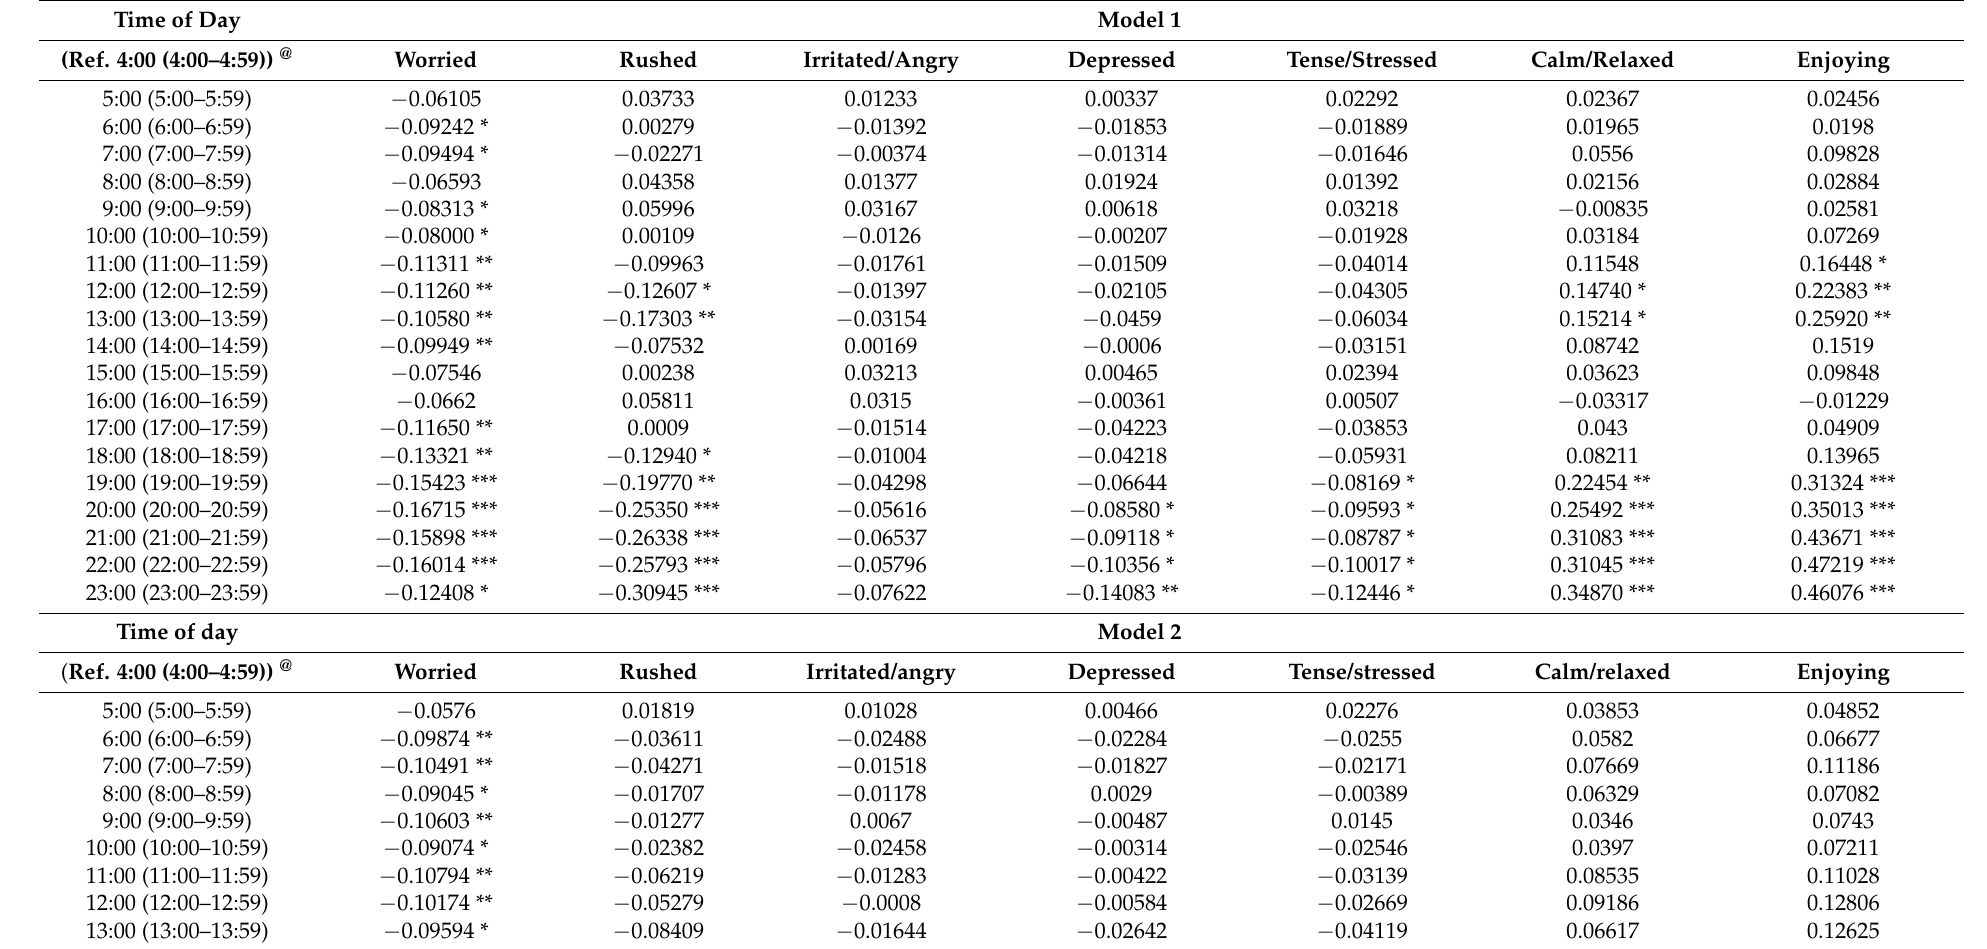
Table A3. Results of multilevel analyses of time of day (ToD) and seven